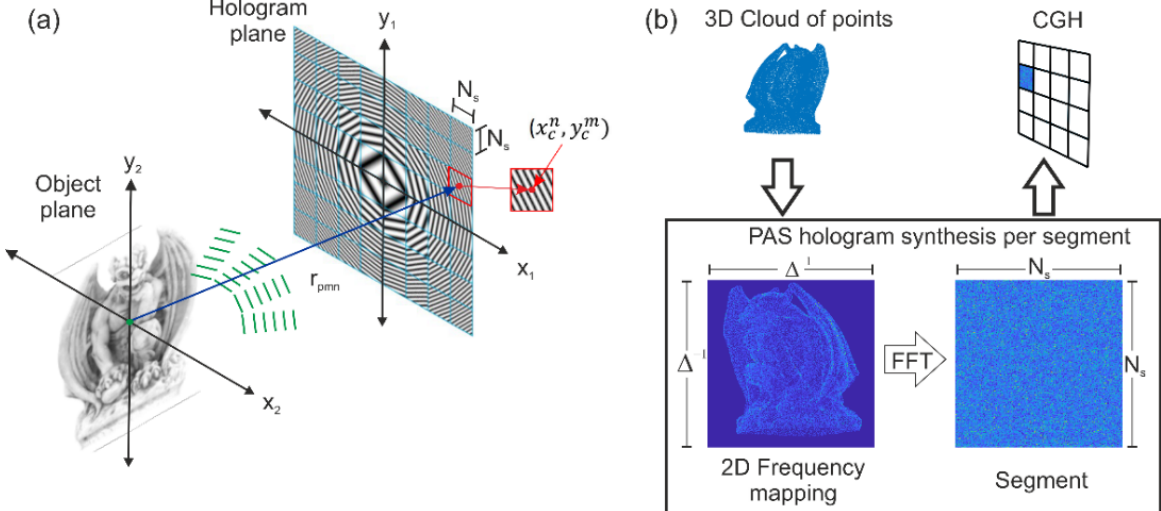
Figure 2. CGH PAS scheme. ( a ) Spherical wavefront decomposition. ( b ) CGH synthesis.